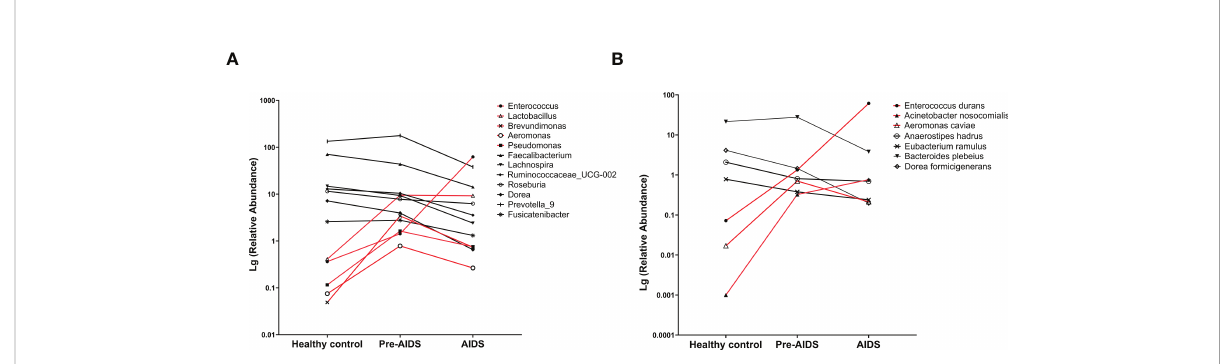
FIGURE 3 Gut microbiota at different stages of HIV infection. Difference of bacterial genera (A) and bacterial species (B) at different stages of HIV infection. Compared with healthy controls, higher abundance bacteria (red lines) and lower abundance bacteria (black lines) in AIDS and pre-AIDS patients were observed.